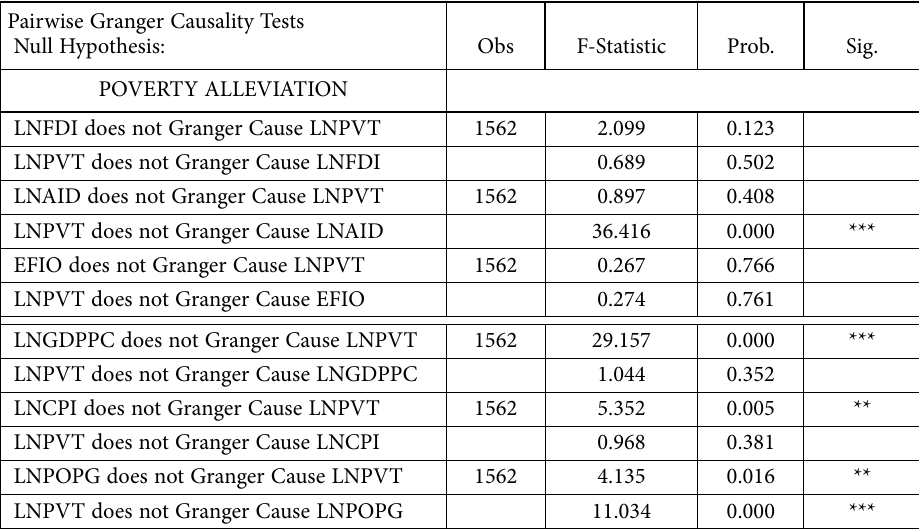
Pairwise Granger Causality Tests Null Hypothesis: